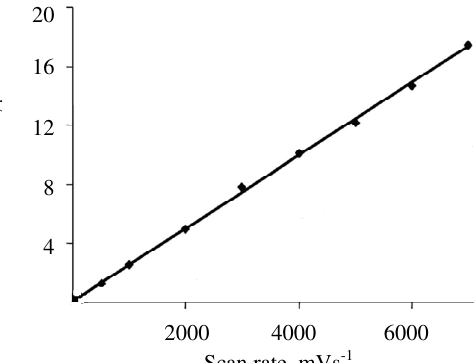
Figure 5. Effect of scan rate on the peak current of 1a (6 x 10 -5 M) at pH=10.5.